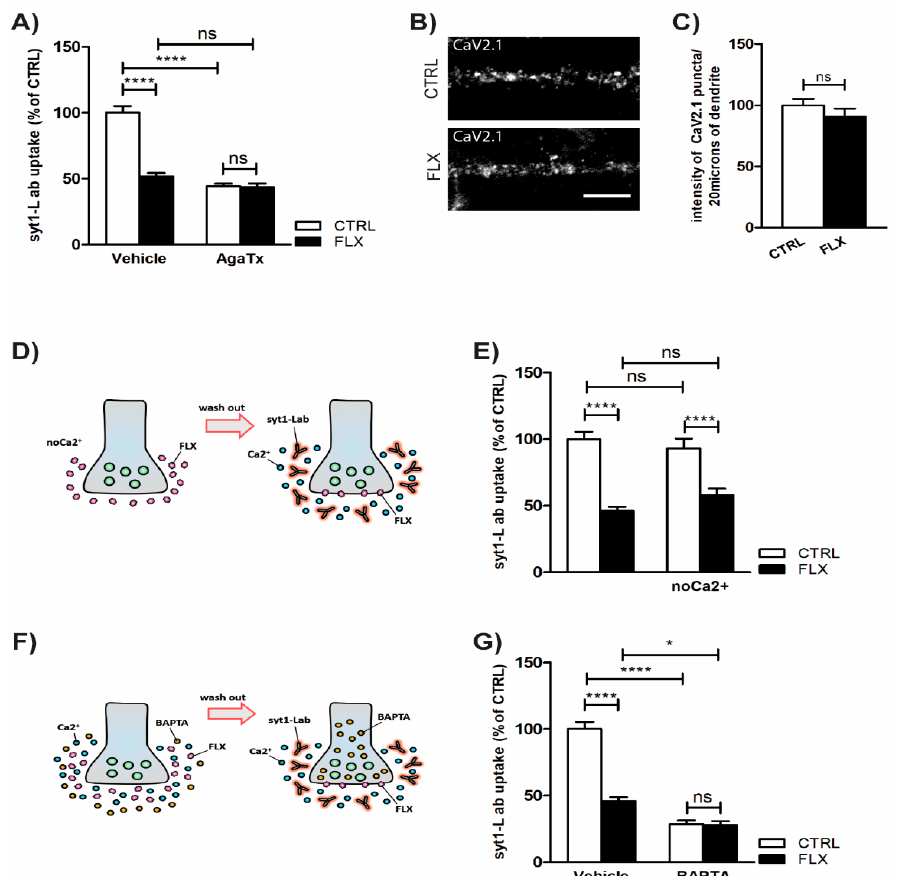
Figure 4. Inhibition of P/Q type Ca 2+ channels mediates FLX-induced suppression of presynaptic activity. ( A ) Statistical analysis of KCl-evoked syt1-L ab uptake from cortical neurons treated with CTRL solution or FLX (100 µM: 90 min) in the presence or absence of CaV2.1 channels antagonist (AgaTx; 0.4 µM) ( n = 25 CTRL cells; n = 20 FLX; n = 28 AgaTx; n = 25 AgaTx/FLX). ( B ) Representative